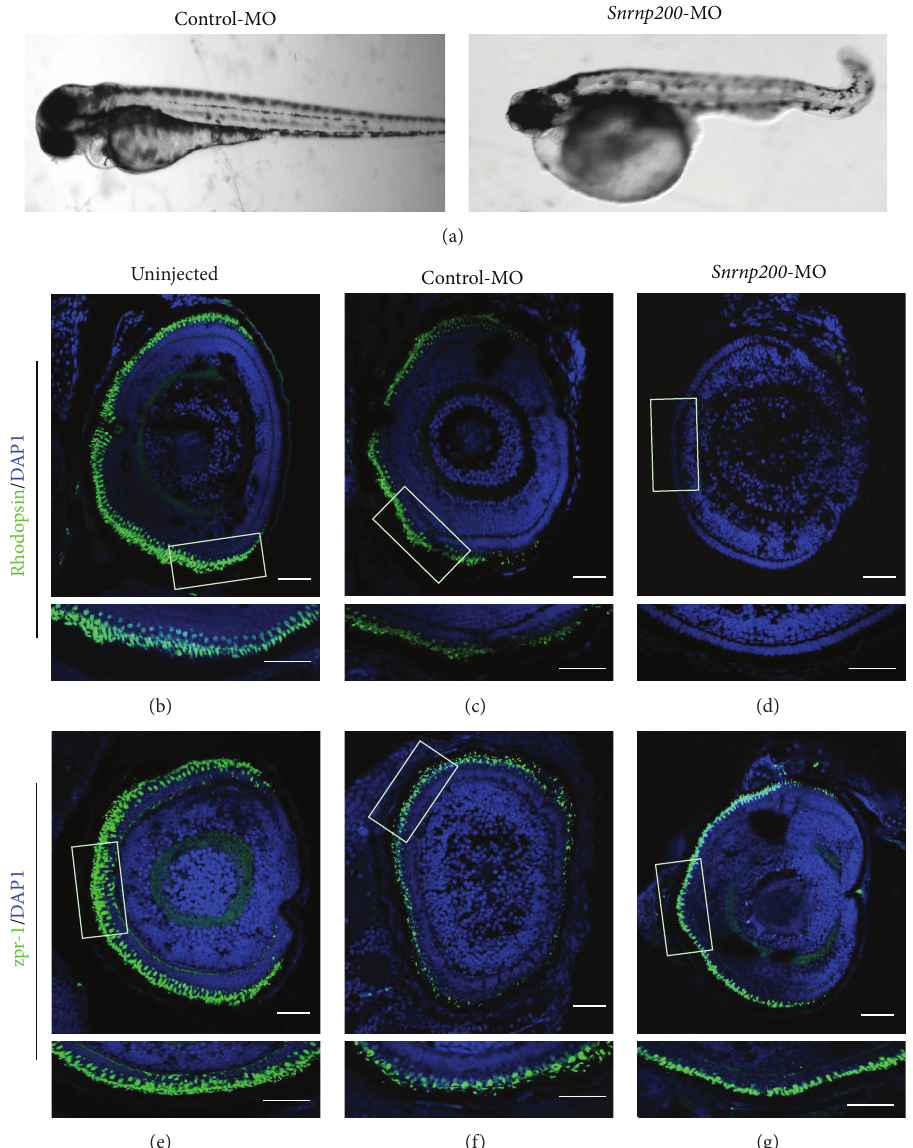
Figure 3: (a) Morphological changes in zebrafish injected with control morpholinos (control-MO) (left) or Snrnp200 -MO (right) at 4 days postfertilization (dpf). Snrnp200 -MO injection would result in morphological changes like malformed brains, short trunks, cardiac edema, and curved body axis, comparing with control-MO injection. (b–g) Retinal frozen sections of uninjected zebrafish (b and e) ( 𝑛 = 12 ) and zebrafish injected with control MO (c and f) ( 𝑛 = 11 ) and with Snrnp200 -MO (d and g) ( 𝑛 = 14 ) were immunostained for rhodopsin (b–d) or zpr-1